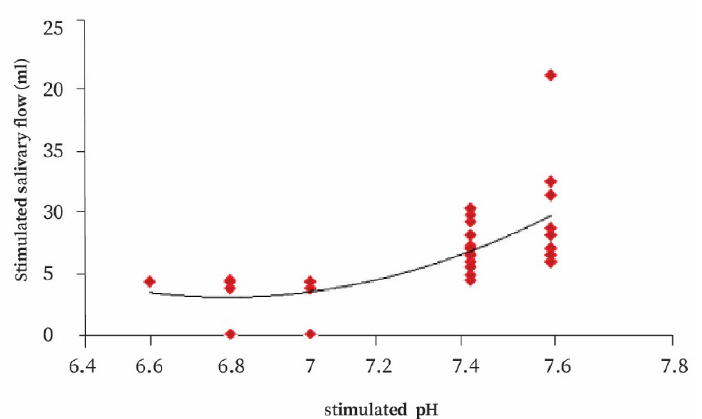
Figure 5. Dependence of the stimulated salivary flow (ml) on the stimulated pH .